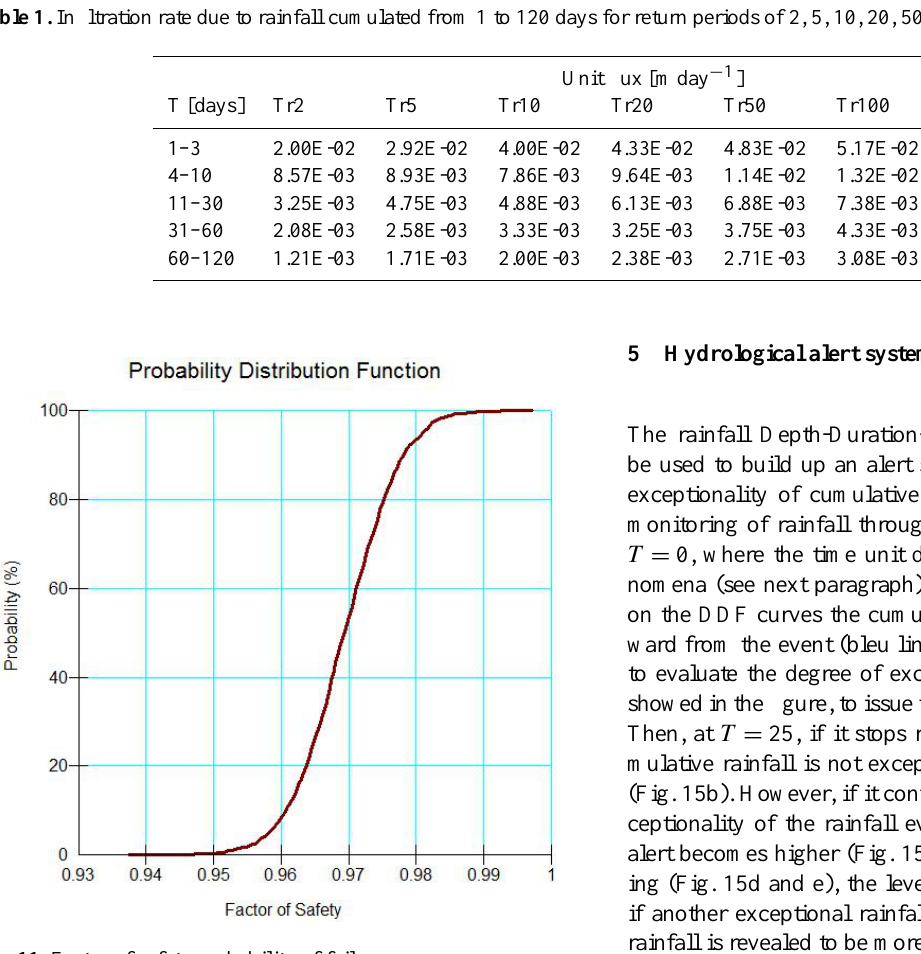
Fig. 11. Factor of safety probability of